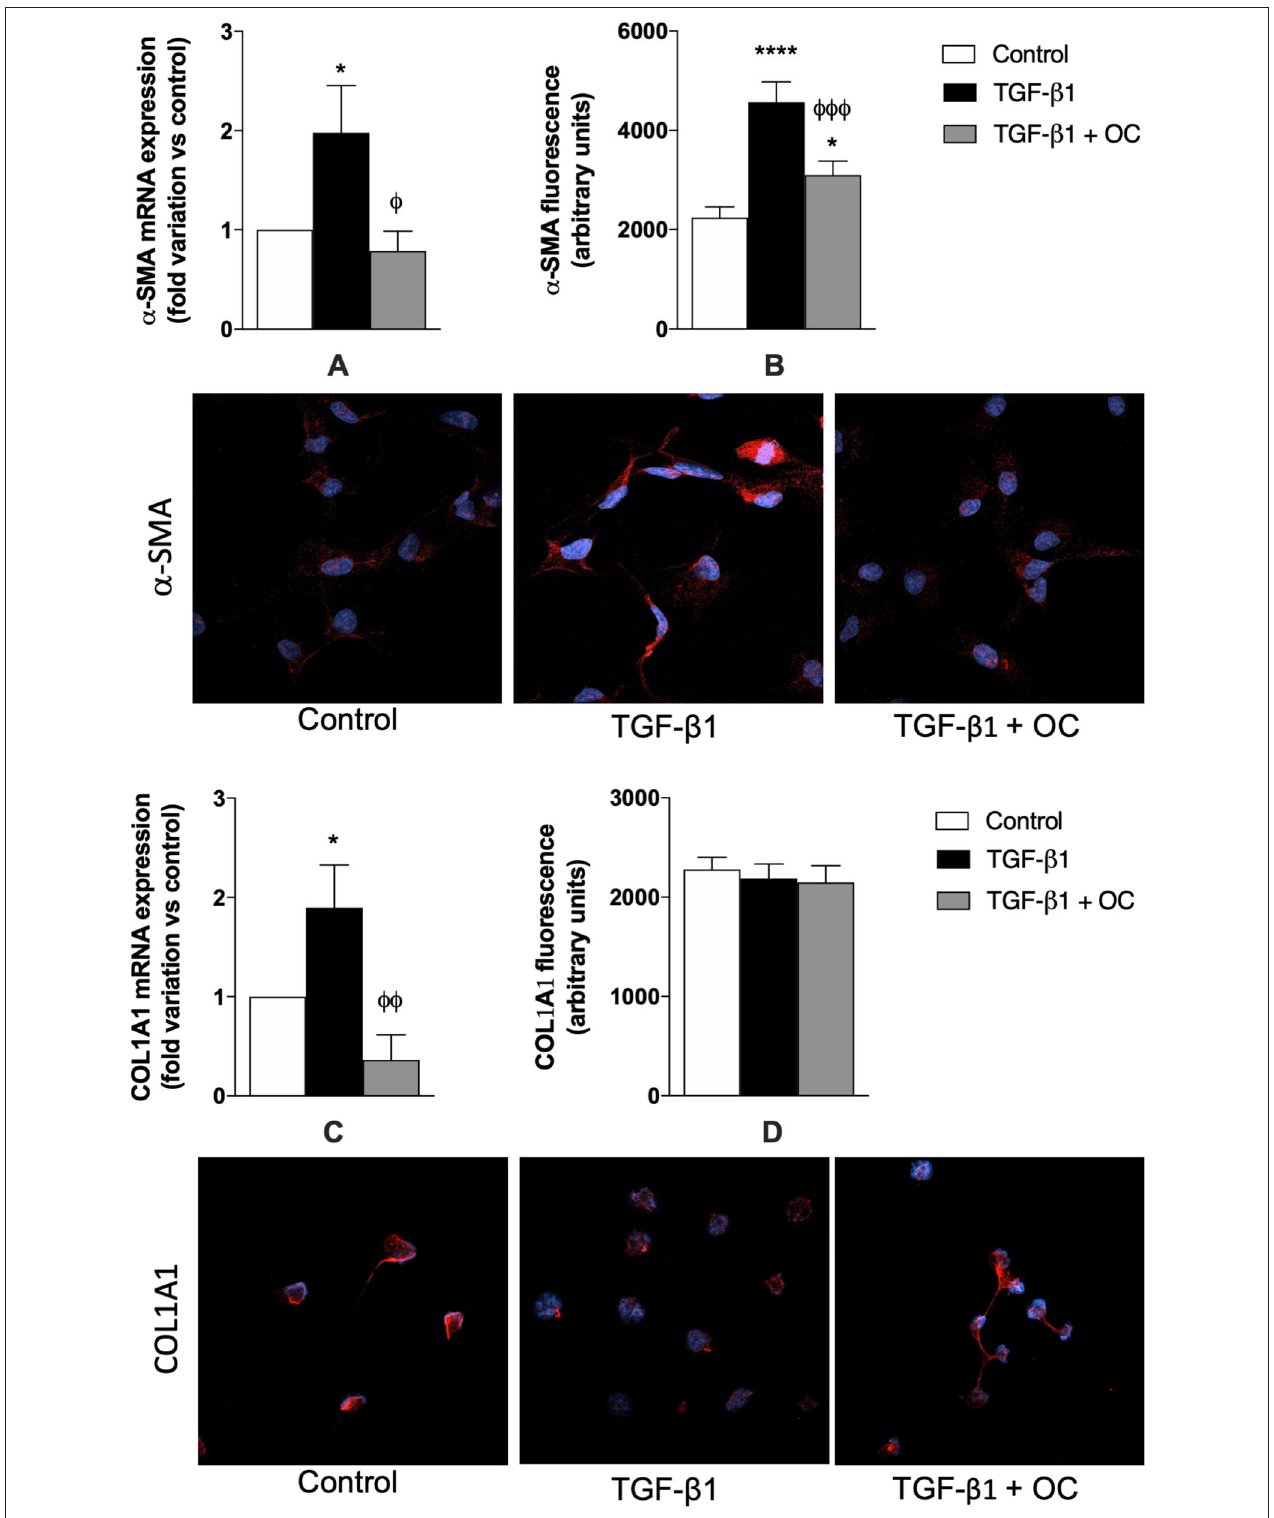
FIGURE 2 | Effect of OC on α -SMA (A, B) and COL1A1 (C, D) mRNA and protein expression in LX2 cell line. * P < 0.05, **** P < 0.0001 vs. control, φ P < 0.05, φφ P < 0.01, φφφ P < 0.001 vs. TGF- β 1 treated cells. Representative images of α -SMA and COL1A1-related red fluorescence are shown. Cell nuclei are stained blue with DAPI. At least 8 fields per coverslip have been analyzed to obtain the quantification of fluorescence. Results are the mean of 3 independent experiments and have been analyzed by one-way ANOVA followed by the Tukey’s post hoc test.